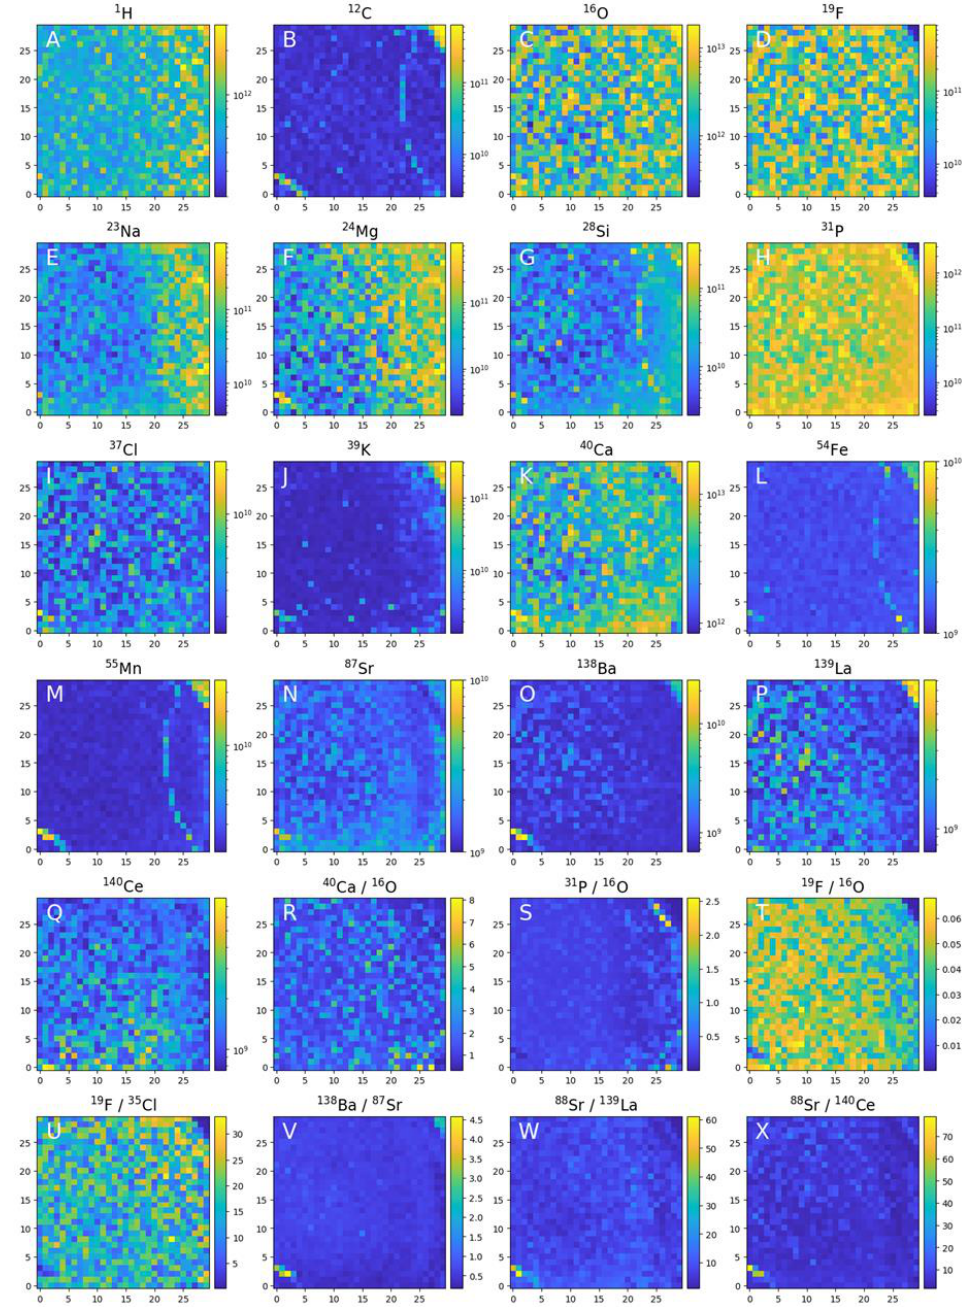
Figure 9. Chemical mapping of the 0.9 × 0.9 mm 2 of the apatite crystal surface embedded in phoscorite rock. Element heterogeneities measured in 900 locations can be used to investigate element analysis, analysis of the neighbouring mineral phases and identification of grain size inclusion of distinct chemical composition with assessing their mineralogical content.